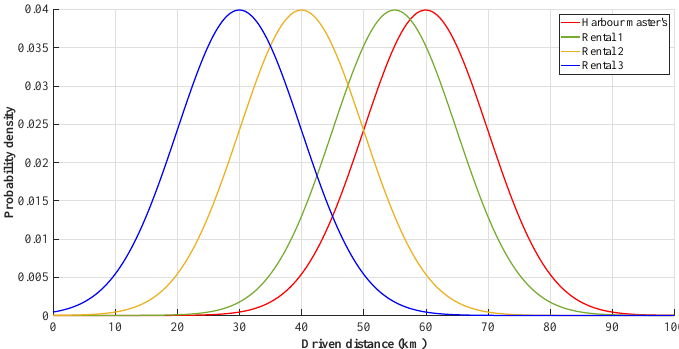
Figure 2. Probability density function for electric cars at Ballen